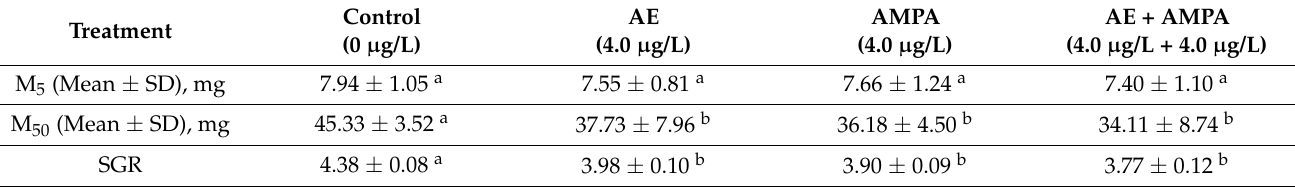
Table 1. Body weight of early life stages of marbled crayfish Procambarus virginalis during a 50-day exposure to acetochlor ESA (AE, N = 31) at 4.0 µ g/L, aminomethylphosphonic acid (AMPA, N = 32) at 4.0 µ g/L and their combination (AE + AMPA, N = 29) each at 4.0 µ g/L, and in control (no exposure, N = 30); different superscripts indicate significant difference among groups ( p <